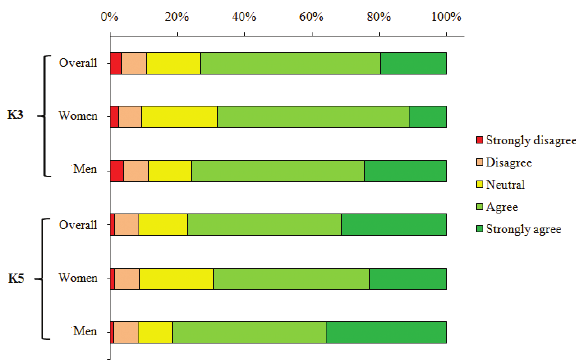
Figure A1. Responses to K1: What is the main source of clean energy?